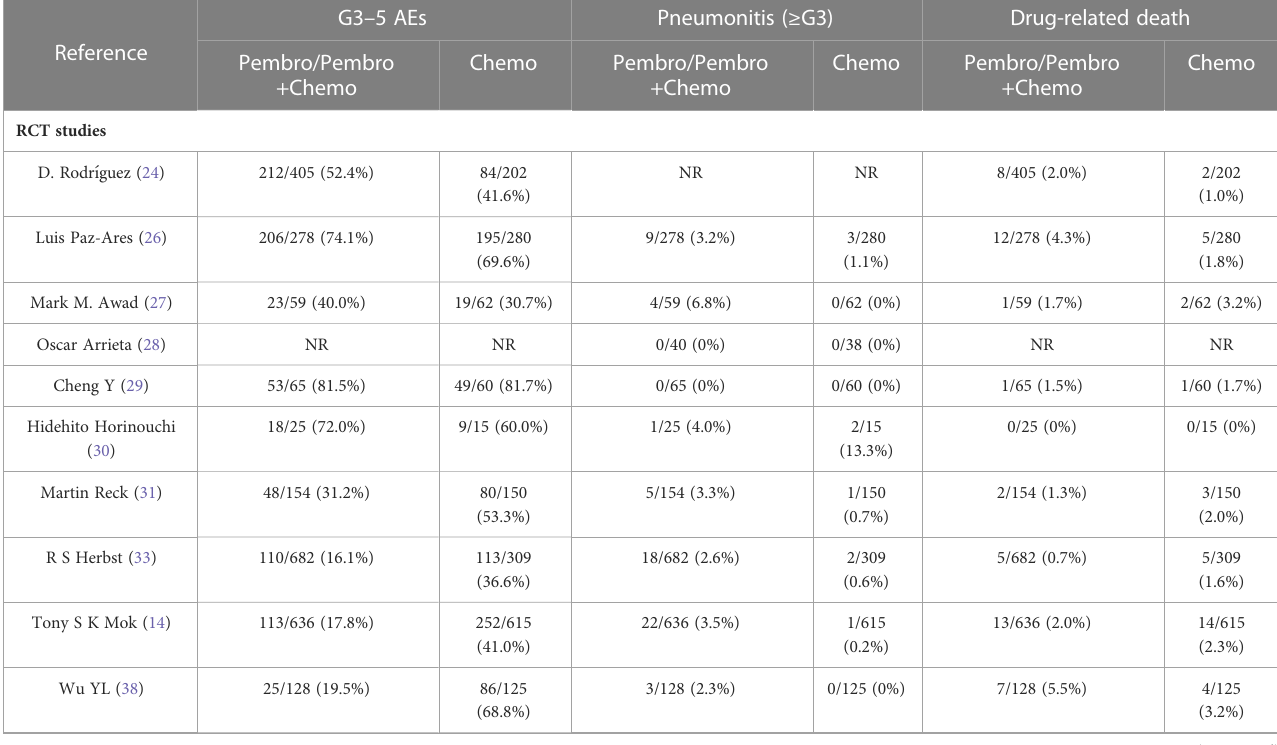
TABLE 4 Safety outcomes of the included studies.